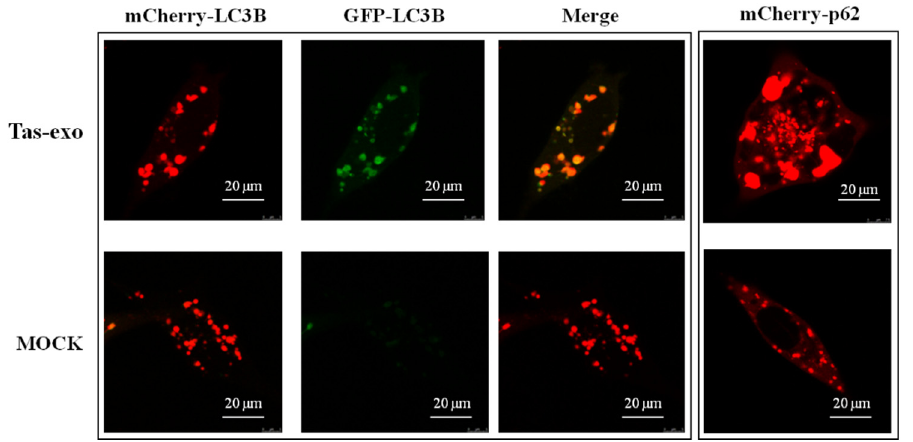
Figure 7. Fluorescent observation of exosome inhibition of LoVo cell autophagy. Fluorescence observed in exosome + Ad-mCherry-GFP-LC3B group and NC group, and exosome + Ad- mCherry-P62. These groups were observed using a laser scanning confocal microscope (LSCM) at 75